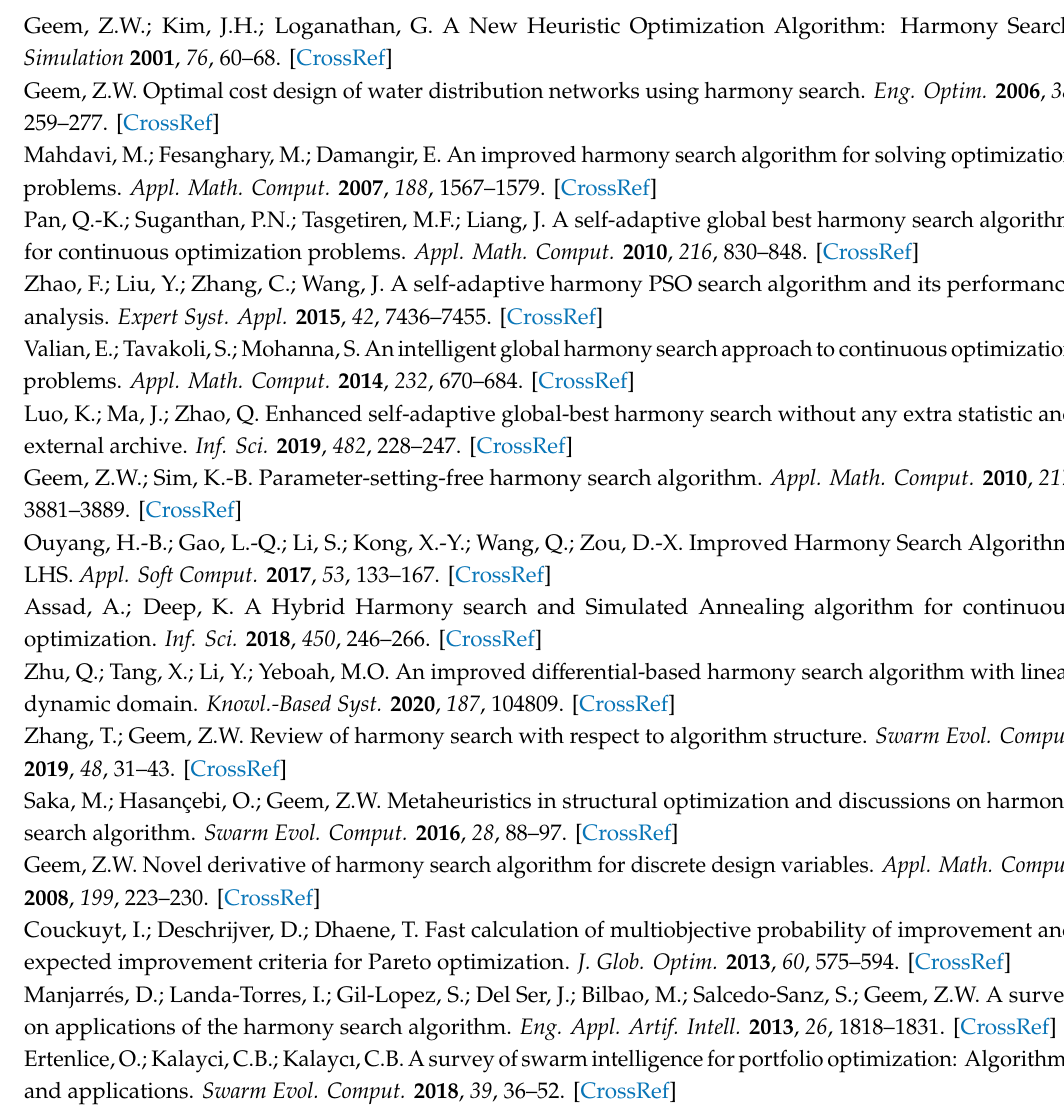
Table S1: Fitness of f10 for di ff erent parameters (PAR, F). Table S2: Fitness of f21 for di ff erent parameters ( PAR , F ). Table S3 : Fitness of f28 for di ff erent parameters ( PAR , F ). Table S4: Performance comparison among five harmony search algorithms for f1–f30 (DIM = 10). Table S5: Performance comparison among five harmony search algorithms for f1–f30 (DIM = 50). Table S6: Performance comparison among five harmony search algorithms for f1–f30 (DIM =